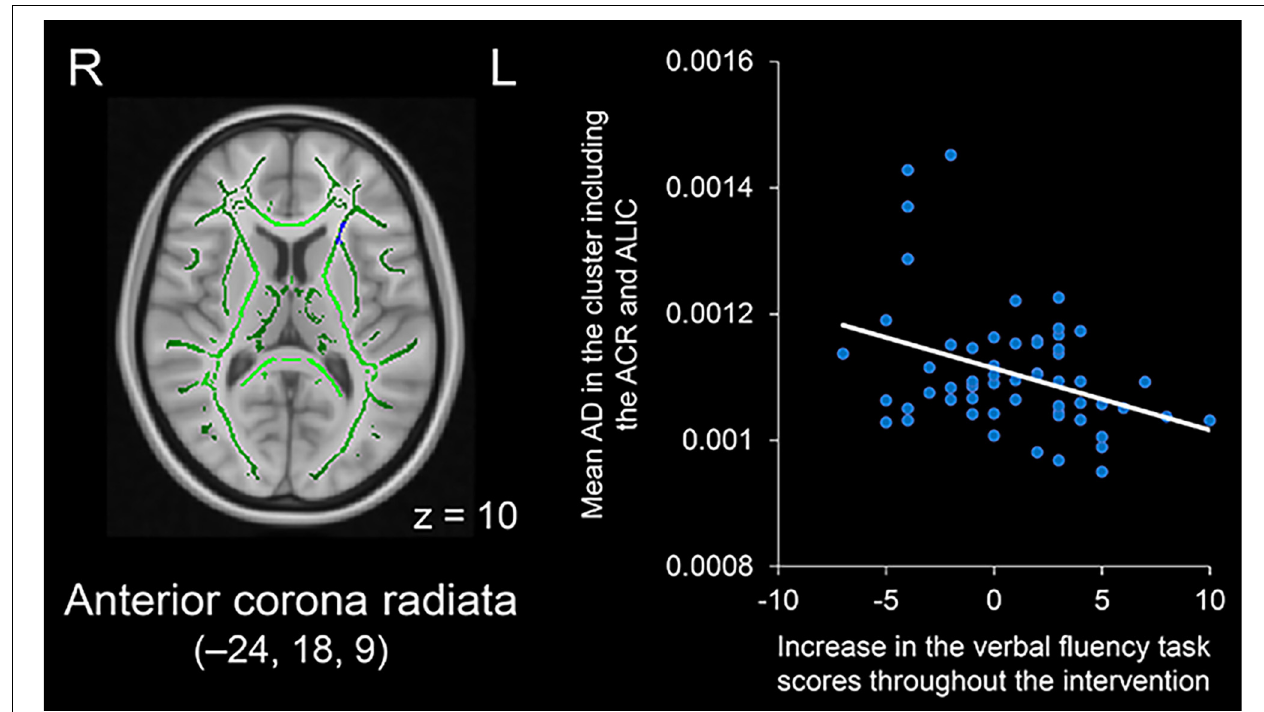
FIGURE 5 | Negative correlation between increases in verbal fluency task scores throughout the intervention period and AD values in the cluster including the left ACR and ALIC (displayed in blue). The cluster is overlaid on the mean FA skeleton (shown in green) and the standard MNI152 T1 1-mm 3 brain template. The value of z in the horizontal plane represents the MNI z -coordinate. MNI coordinates of the peak voxel are x = –24, y = 18, z = 9. Abbreviations: ACR, anterior corona radiata; AD, axial diffusivity; ALIC, anterior limb of the internal capsule; FA, fractional anisotropy; L, left; MNI, Montreal Neurological Institute; R, right.